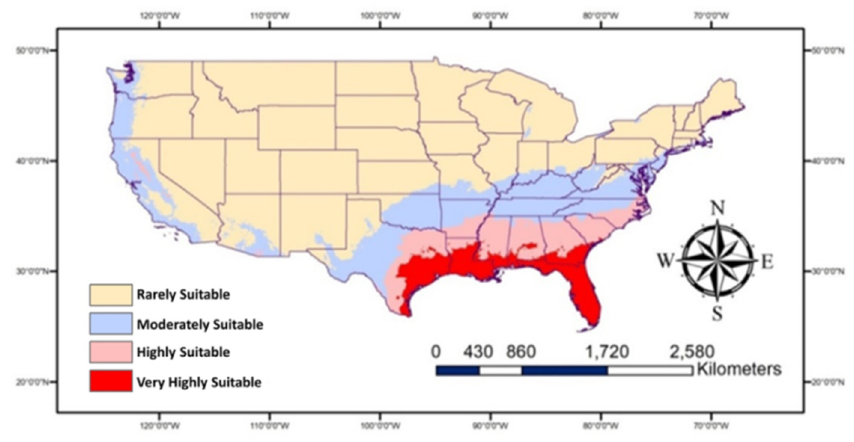
Figure 4. Map showing historic/current habitat suitable for Plecia nearctica in the USA.